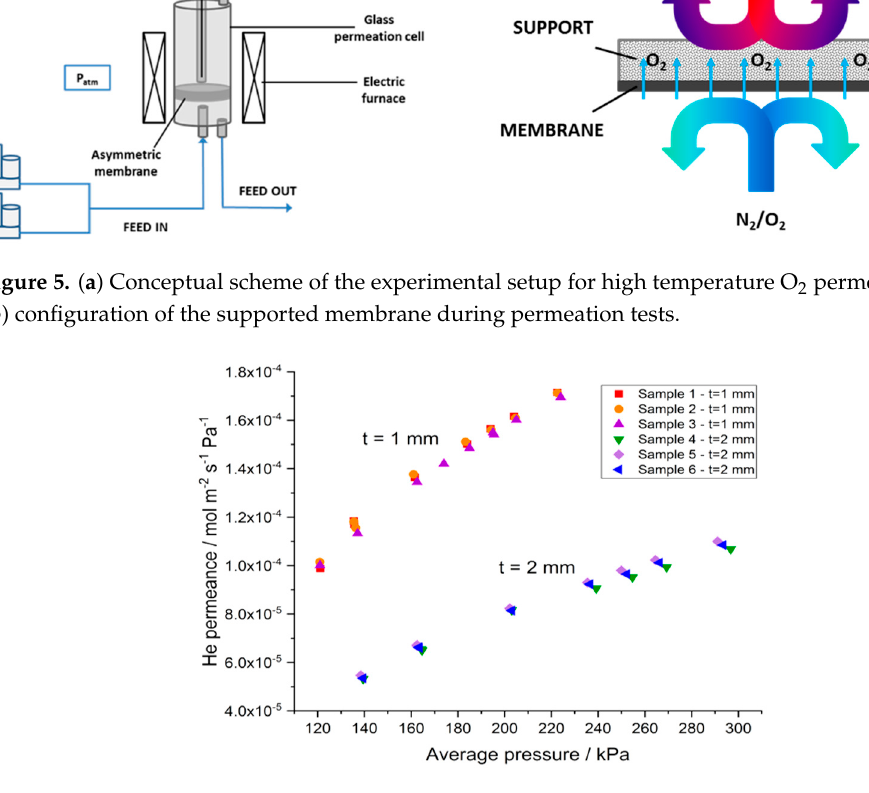
Figure 6. Helium permeance as a function of the average pressure measured across the sample.